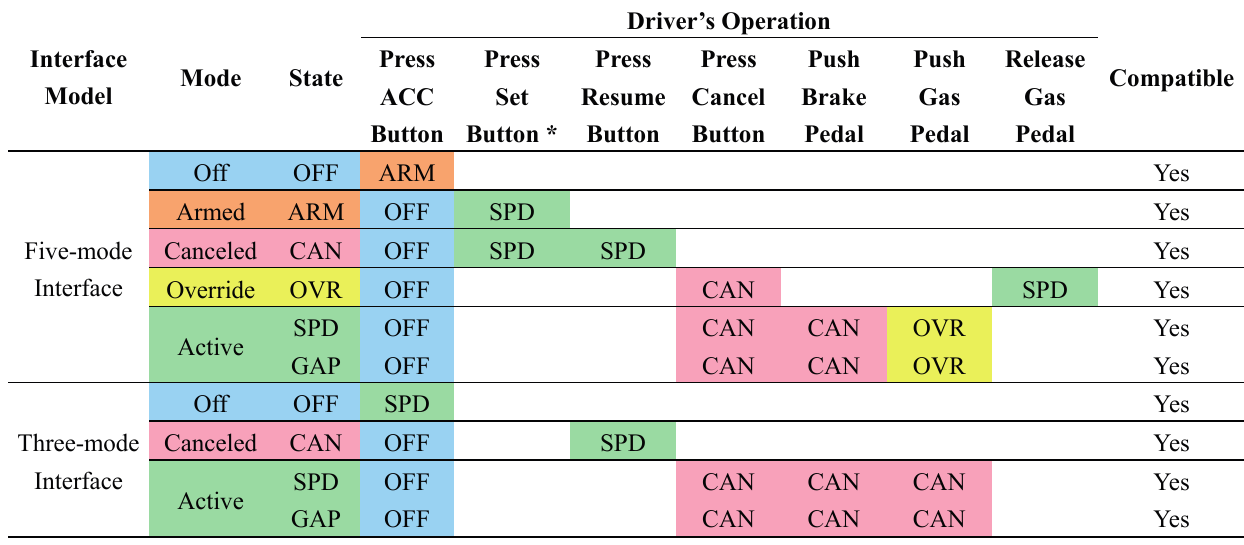
Table 5. User-triggered transitions between states and modes in the new interface models. Interface